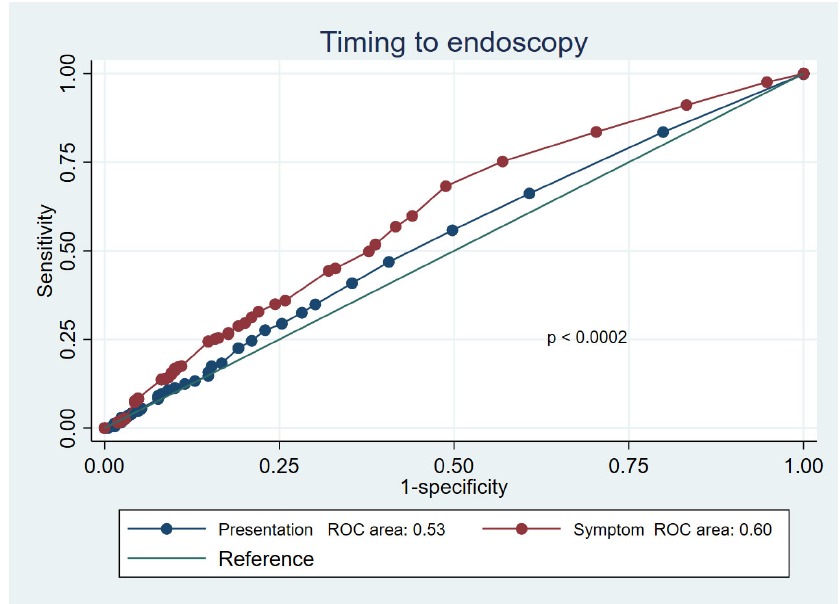
Figure 2. The di ff erences in the prediction of mortality risk between the two timeframes. Table 5. The multivariate mortality risk according to the two sets of